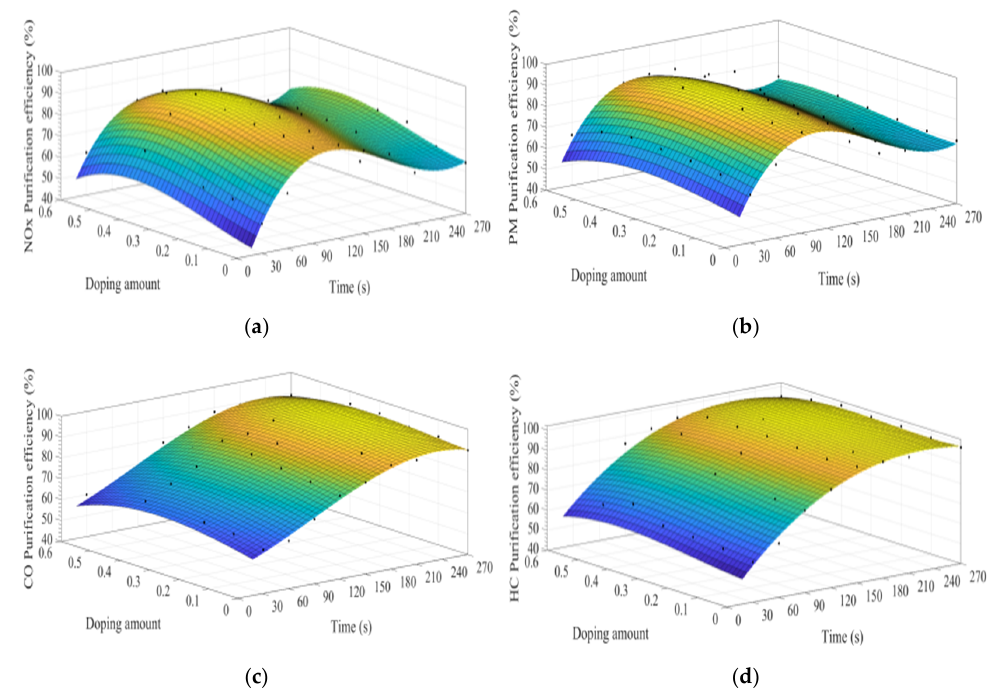
Figure 13. Purification efficiency curve of catalyst when B site was doped with iron ions: ( a ) NO x ; ( b ) PM; ( c ) CO; and ( d ) HC.